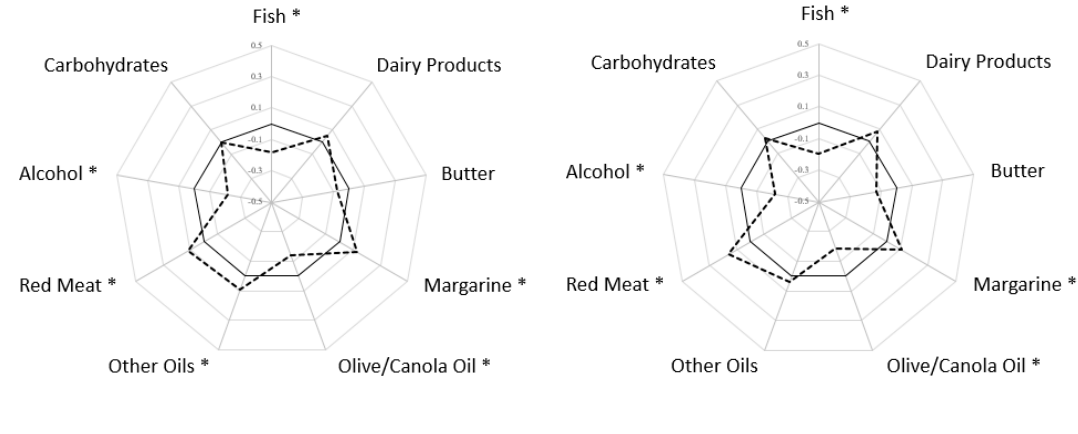
Figure A2. The adjusted Spearman correlations a between plasma phospholipid fatty acids and select food groups. ( A ) Correlations between selected food groups and plasma PL long-chain SFA ( B ) Correlations between selected food groups and plasma PL PUFA n-3 ( C ) Correlations between selected food groups and plasma PL PUFA n-6 ( D ) Correlations between selected food groups and plasma PL TFA. a Correlations were adjusted for matching factors (age, race / ethnicity, enrollment date, and hysterectomy status), income, lifestyle factors (physical activity and smoking), and CHD risk factors (family history of myocardial infarction / diabetes, postmenopausal hormone use, and self-reported hypertension / diabetes). Solid line—reference line of 0 Spearman correlations. Dashed line—Spearman correlations among controls. * Significant Spearman correlations with p value < 0.0001. Abbreviations: CHD (coronary heart disease), PL (phospholipid), PUFA (polyunsaturated fatty acids), SFA (saturated fatty acids), TFA ( trans fatty acids).